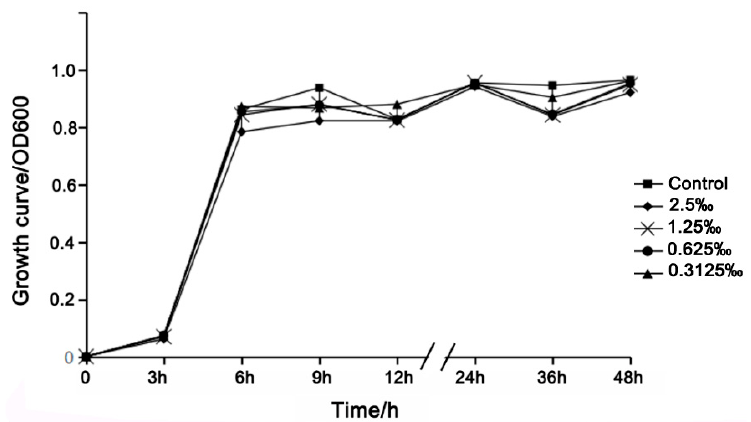
Figure 3. The e ff ect of di ff erent concentrations of C. camphora EO on the growth of C. violaceum . Figure 3. The effect of different concentrations of C. camphora EO on the growth of C. violaceum .